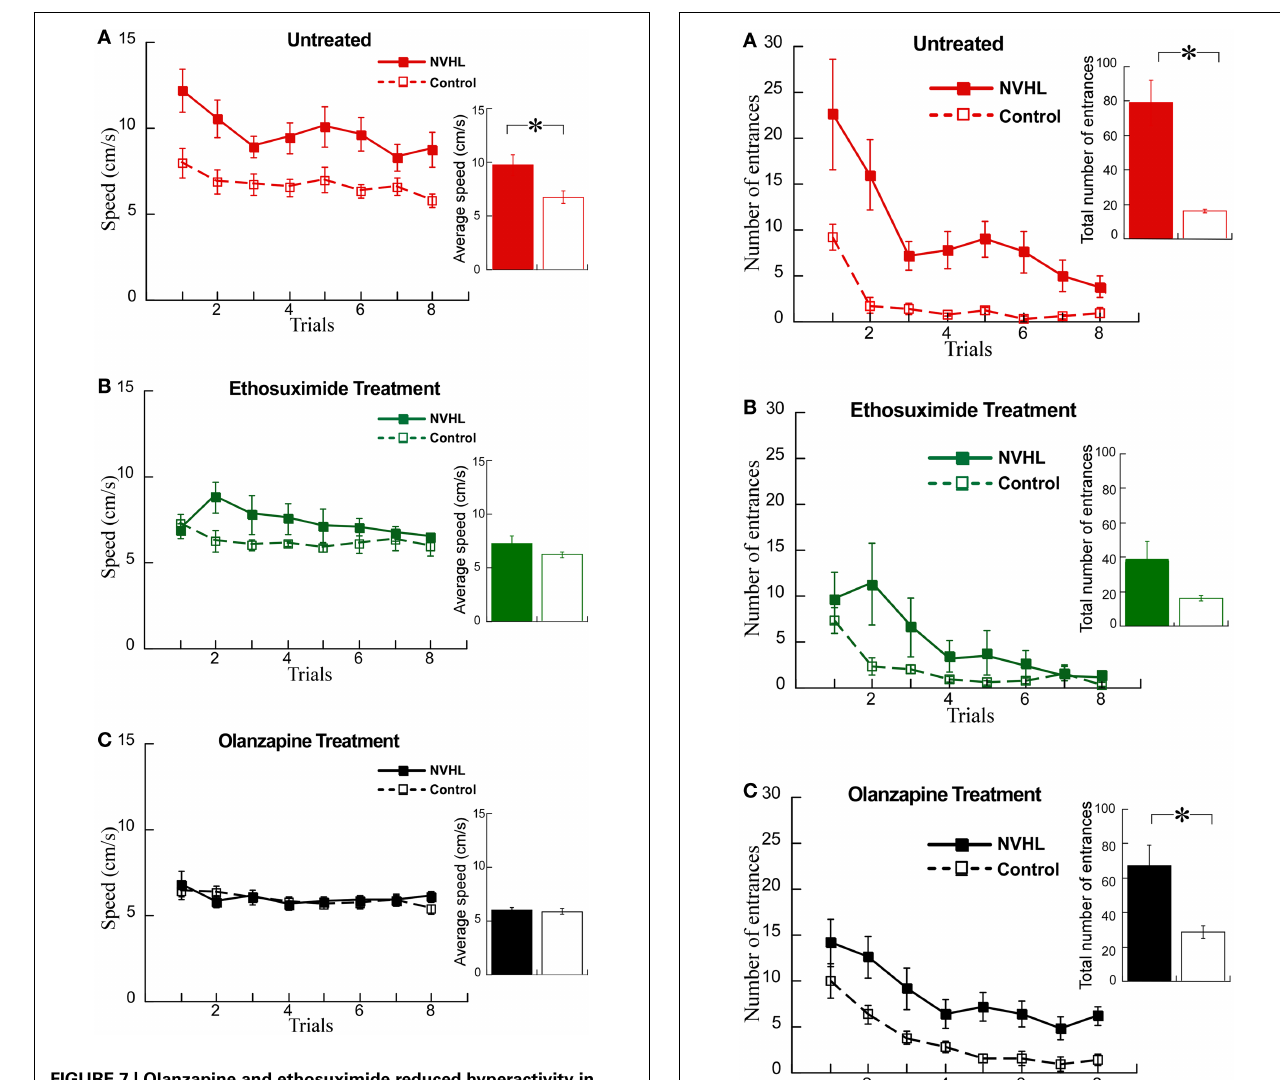
FIGURE 7 | Olanzapine and ethosuximide reduced hyperactivity in NVHL rats . (A) In the untreated group, the NVHL rats were hyperactive compared to control rats while performing the two-frame avoidance task (performance curve: two-way repeated-measures ANOVA group: F 1,64 = 53.34, p < 0.0001; trial: F 7,64 = 2.37, p = 0.03; interaction: F 7,64 = 0.46, p = 0.86); inset: average speed: t 8 = 2.78, p = 0.02). (B) Ethosuximide treatment reduced hyperactivity in the NVHL rats compared to untreated NVHL rats, and showed a statistical difference when compared to control rats (performance curve: two-way repeated-measures ANOVA group: F 1,64 = 11.68, p = 0.001; trial: F 7,64 = 0.86, p = 0.54; interaction: F 7,64 = 1.09, p = 0.38); inset: average speed: t 8 = 1.5, p = 0.17). (C) Olanzapine treatment reduced hyperactivity so there was no longer a difference from control rats (performance curve: two-way repeated-measures ANOVA group: F 1,64 = 0.36, p = 0.55; trial: F 7,64 = 1.37, p = 0.23; interaction: F 7,64 = 0.48, p = 0.85); inset: average speed: t 8 = 0.30, p = 0.77).